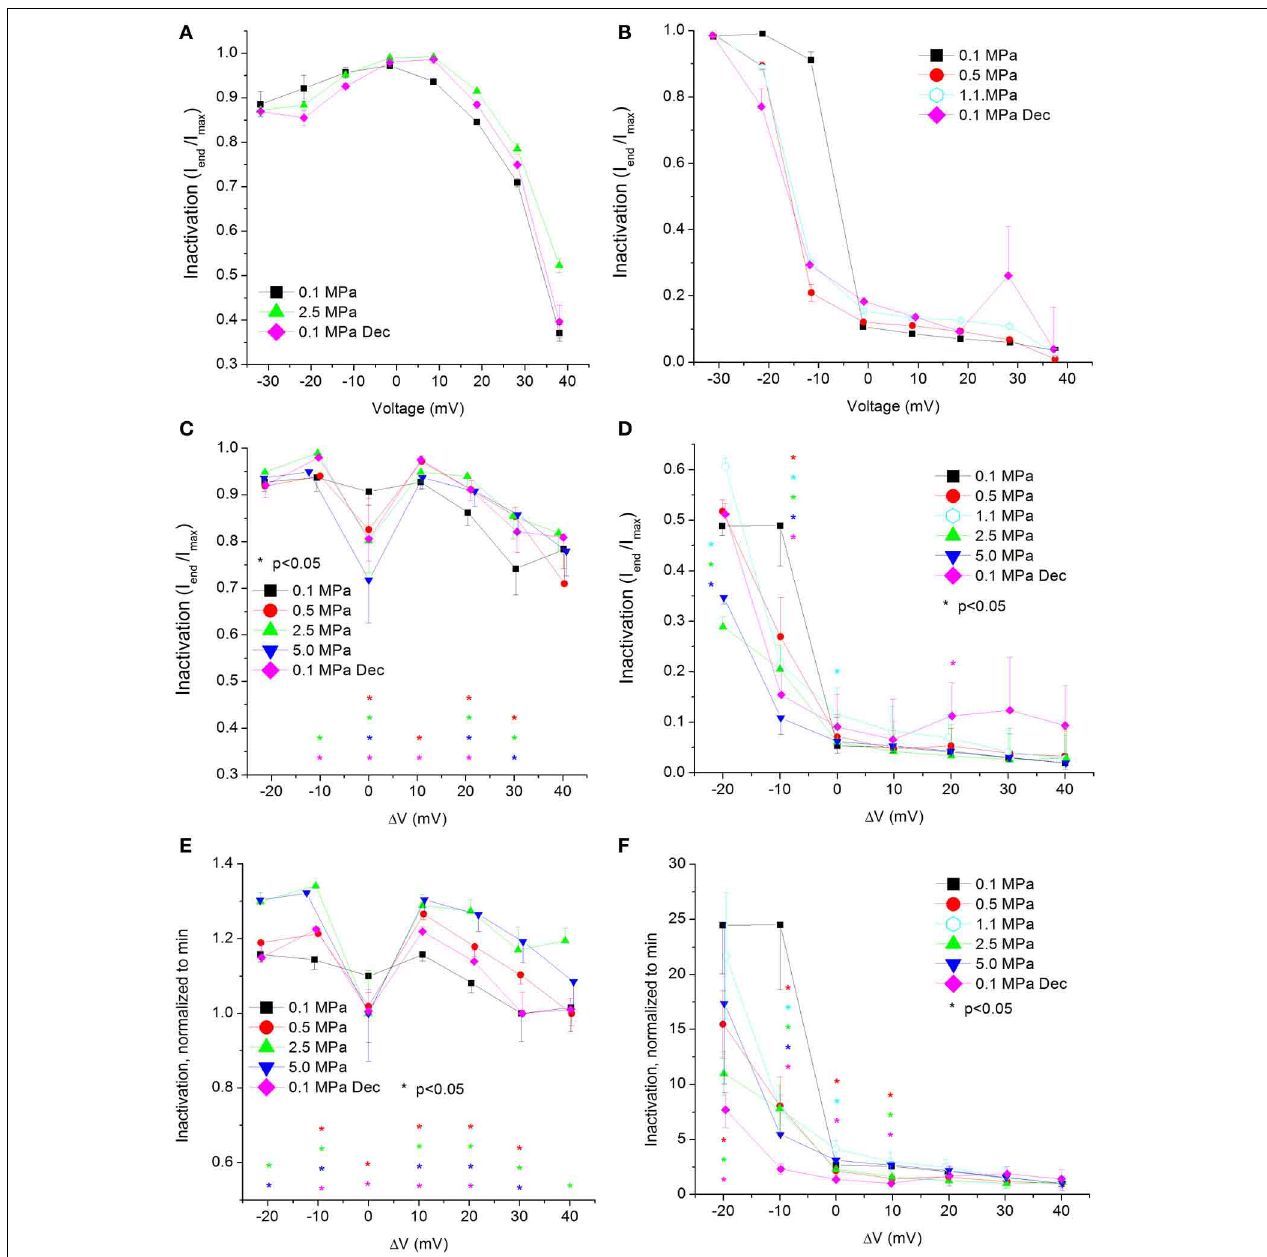
FIGURE 5 | Voltage- and time-dependent current inactivation (I end /I max ) at various pressures. (A,C,E) In Ca V 1.2 and (B,D,F) in Ca V 3.2 channels. (A,B) Inactivation measured in a single oocyte. (C,D) Pooled data of the channels. (E,F) Normalized inactivation: each curve is normalized to its own minimal